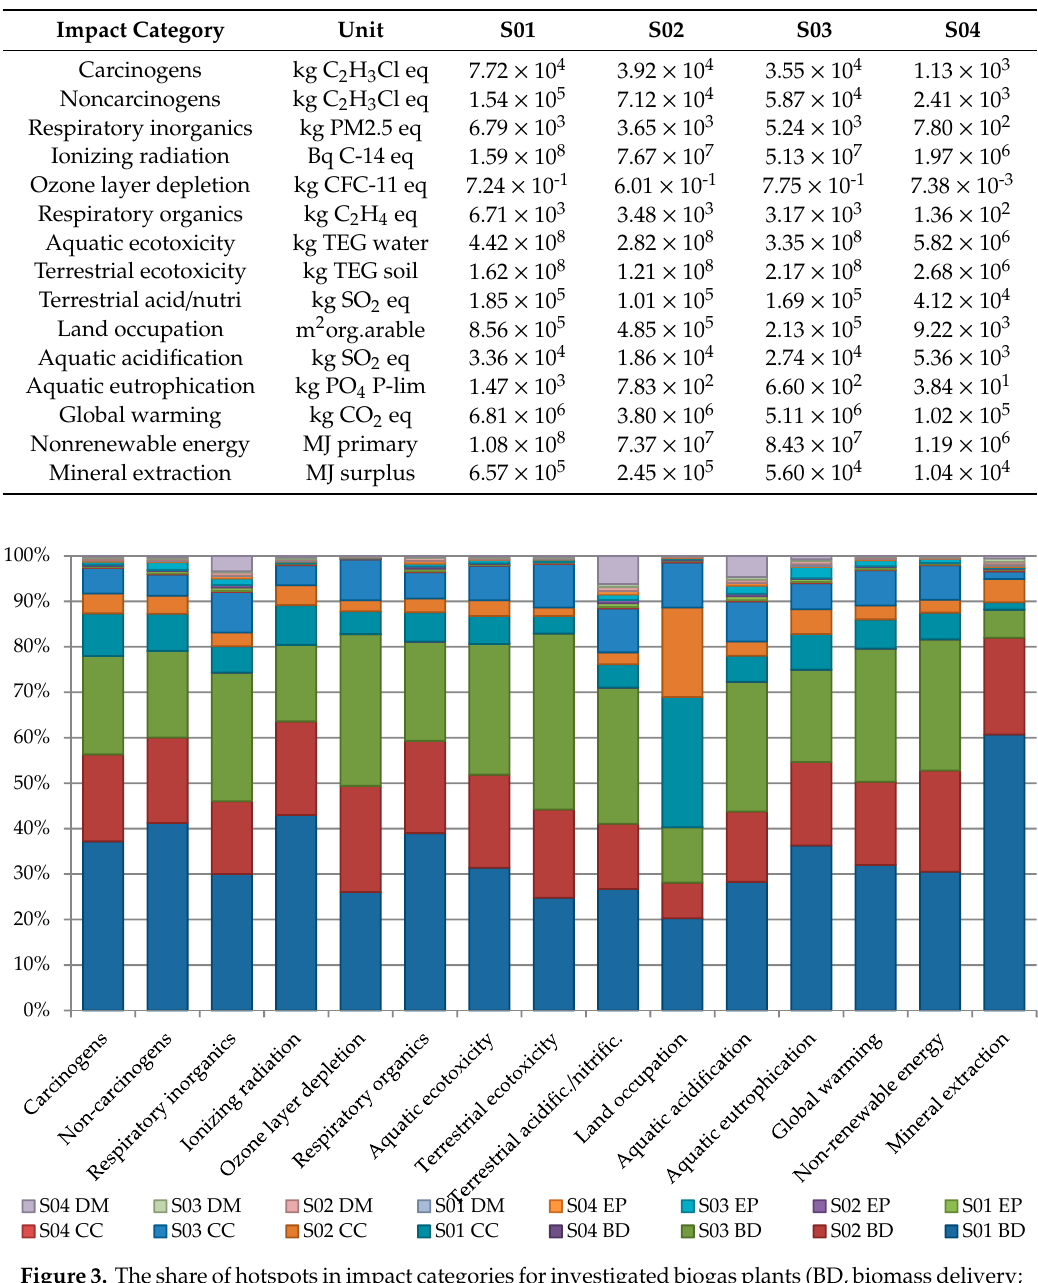
Table 4. Characterization of environmental impact for functional units (FUs) produced in four di ff erent biogas plants based on SimaPro calculations, Impact 2002 + method.